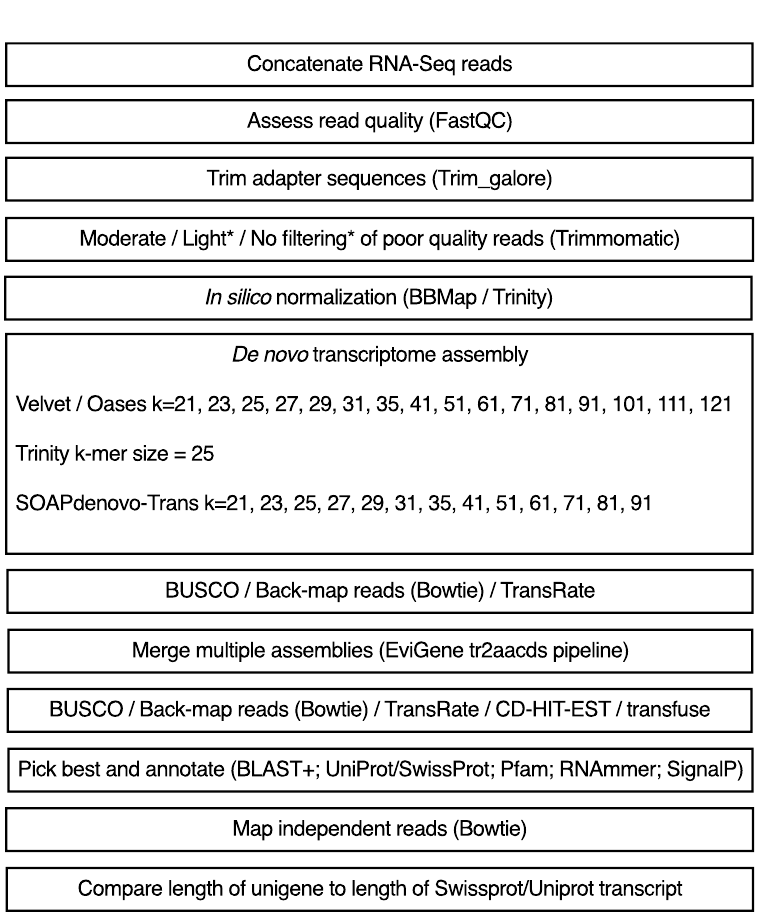
Figure 1. Flow chart of transcriptome assembly pipeline. * SEECER probabilistic error correction conducted on these